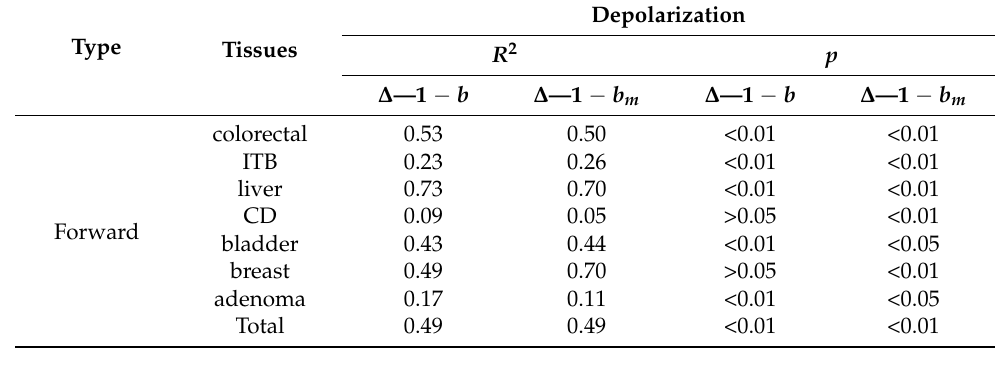
Table 8. Correlation and statistical analysis comparison results between forward measured MMT and MMPD depolarization parameters for each kind of thin tissue samples.